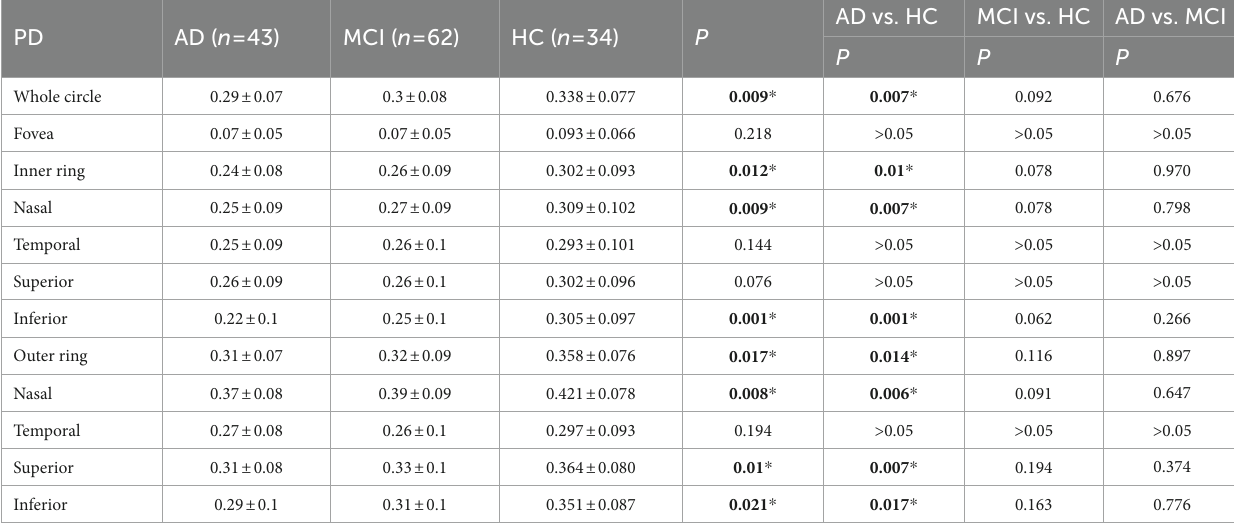
TABLE 4 Comparison of perfusion density in macular among the three groups.